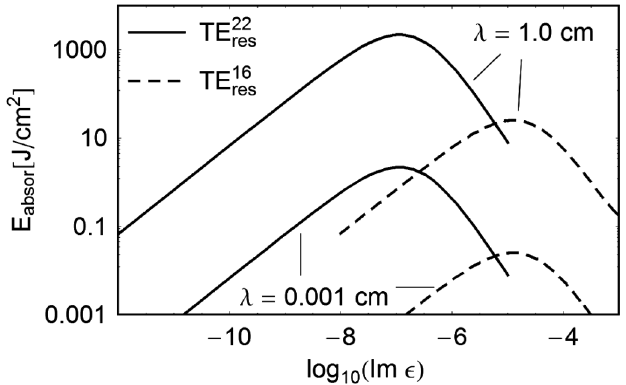
FIG. 12. Absorbed fluence at two WGM resonances and two wavelengths as the function of Im (cid:1)